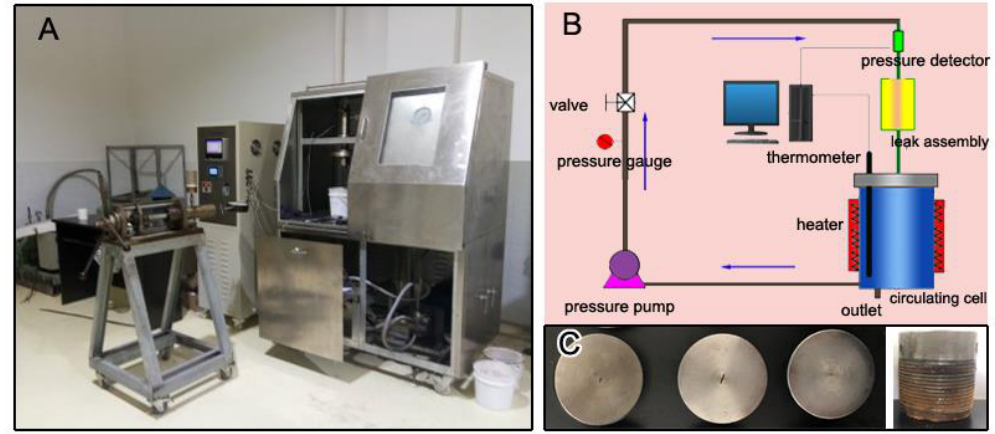
Figure 2. The designed high temperature, high-pressure (HTHP) dynamic sealing detector. ( A ) Photograph of the designed sealing instrument, ( B ) schematic of the sealing instrument, and ( C ) two kinds of modeled defects: cracks (left) and screw damage (right).